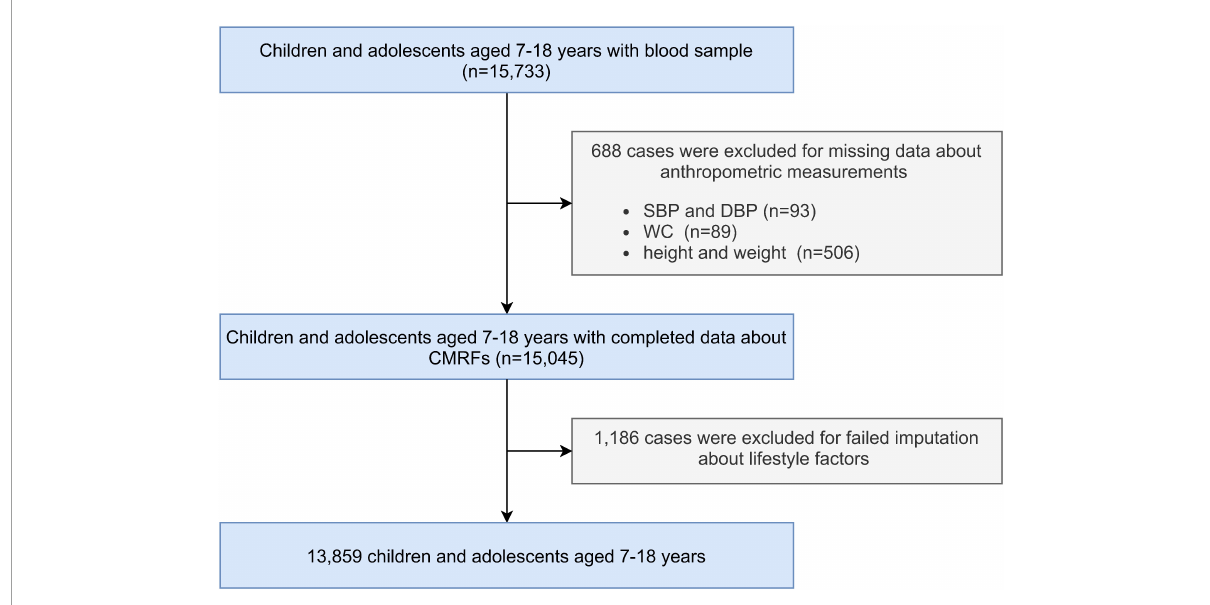
FIGURE1 Flow chart of participants’ inclusion. SBP, systolic blood pressure; DBP, diastolic blood pressure; WC, waist circumference; CMRFs, cardio-metabolic risk factors.